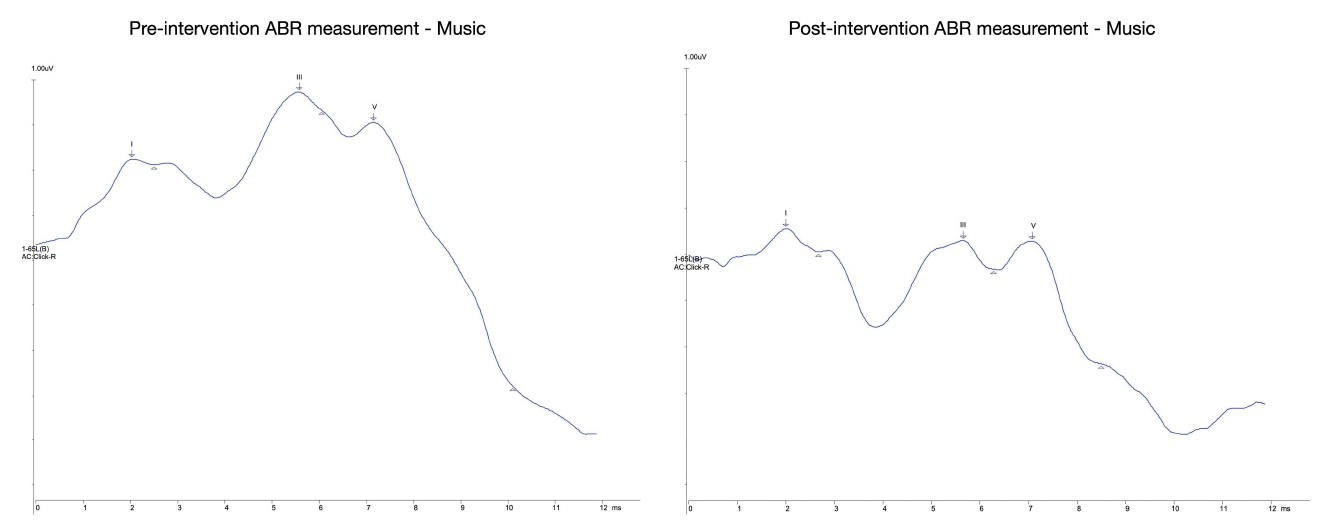
Figure 2. Averaged waveforms for the MEG (pre-post intervention). Table 2. Summative averaged values of wave peaks I, III, V, and interpeak differences for the music and story cohort (AR = amplitude ratio) .